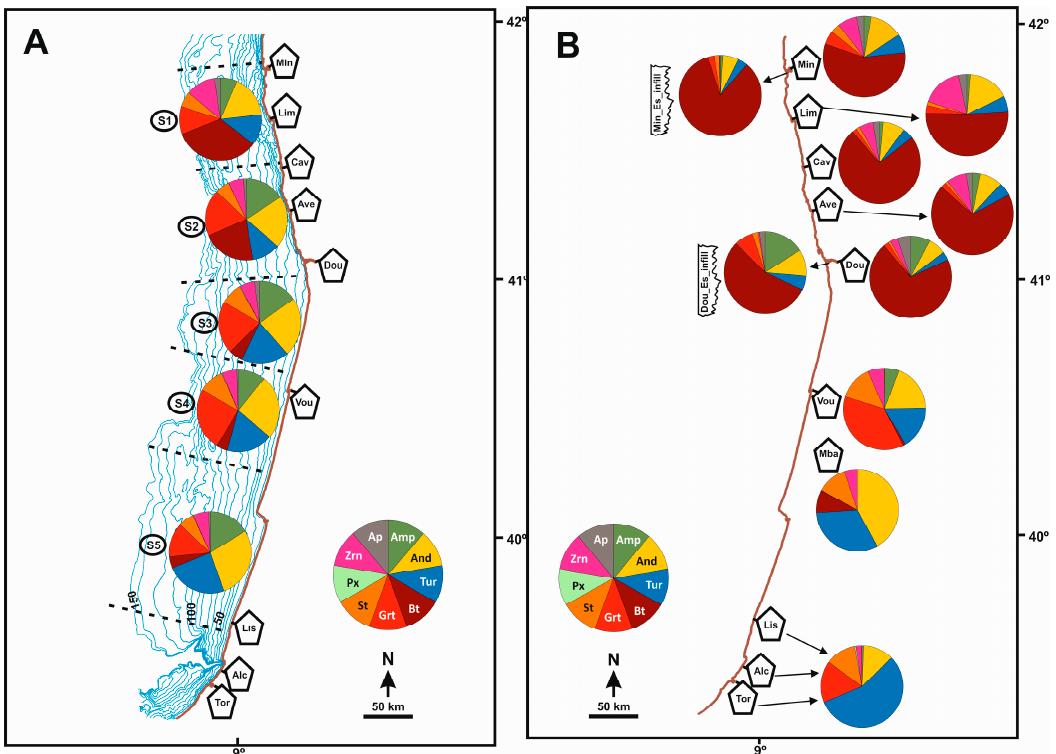
Figure 3. Heavy mineral previous data from diverse locations. ( A ) NW Portuguese continental shelf, five sectors (S1–S5). (B) River sediments: Minho (Min), Lima (Lim), Cávado (Cav), Ave (Ave), Douro (Dou), Vouga (Vou), Lis (Lis), Alcoa (Alc), and Tornada (Tor). Estuaries sedimentary infill: Minho (Min_Es_infill) and Douro (Dou_Es_infill). Continental sedimentary deposits: Mondego basin sediments (Mba). The heavy mineral relative frequencies were extracted from [9–11,31–34].